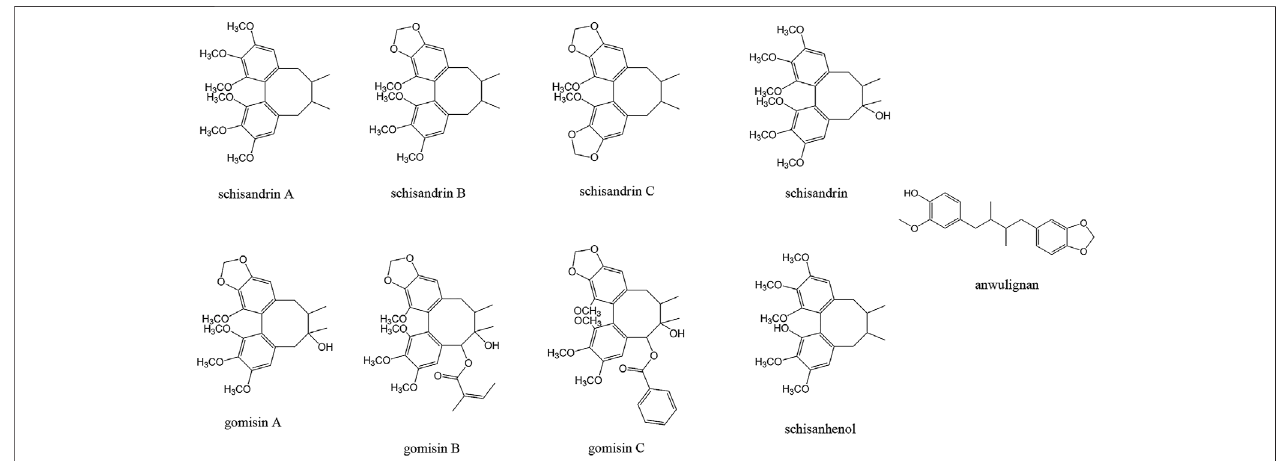
FIGURE 1 | Structure of the major lignan components of Wu Wei